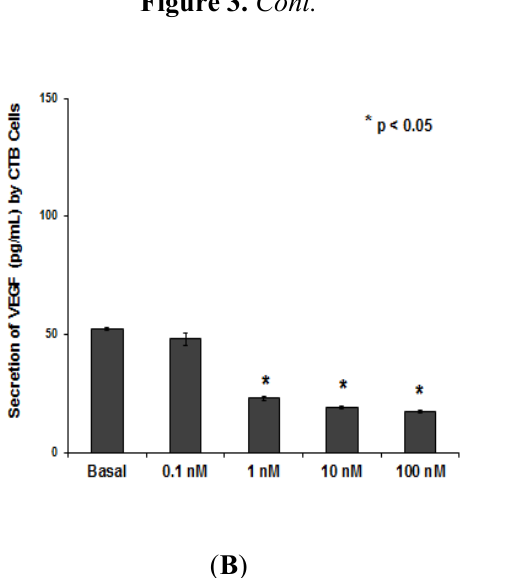
( B ) Receptor Expression and Upregulated AT 1